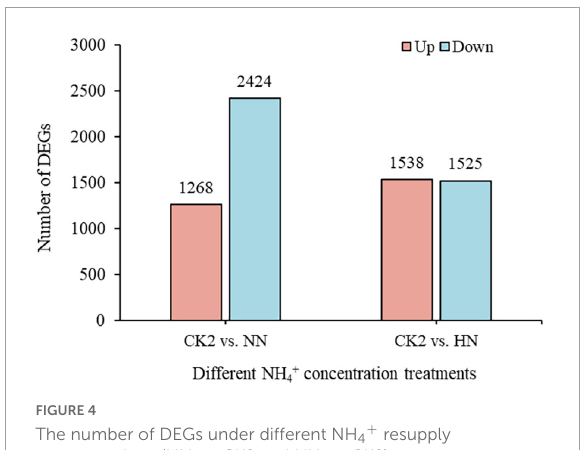
FIGURE4 The number of DEGs under different NH 4 + resupply concentrations (HH vs. CK2 and NN vs. CK2).